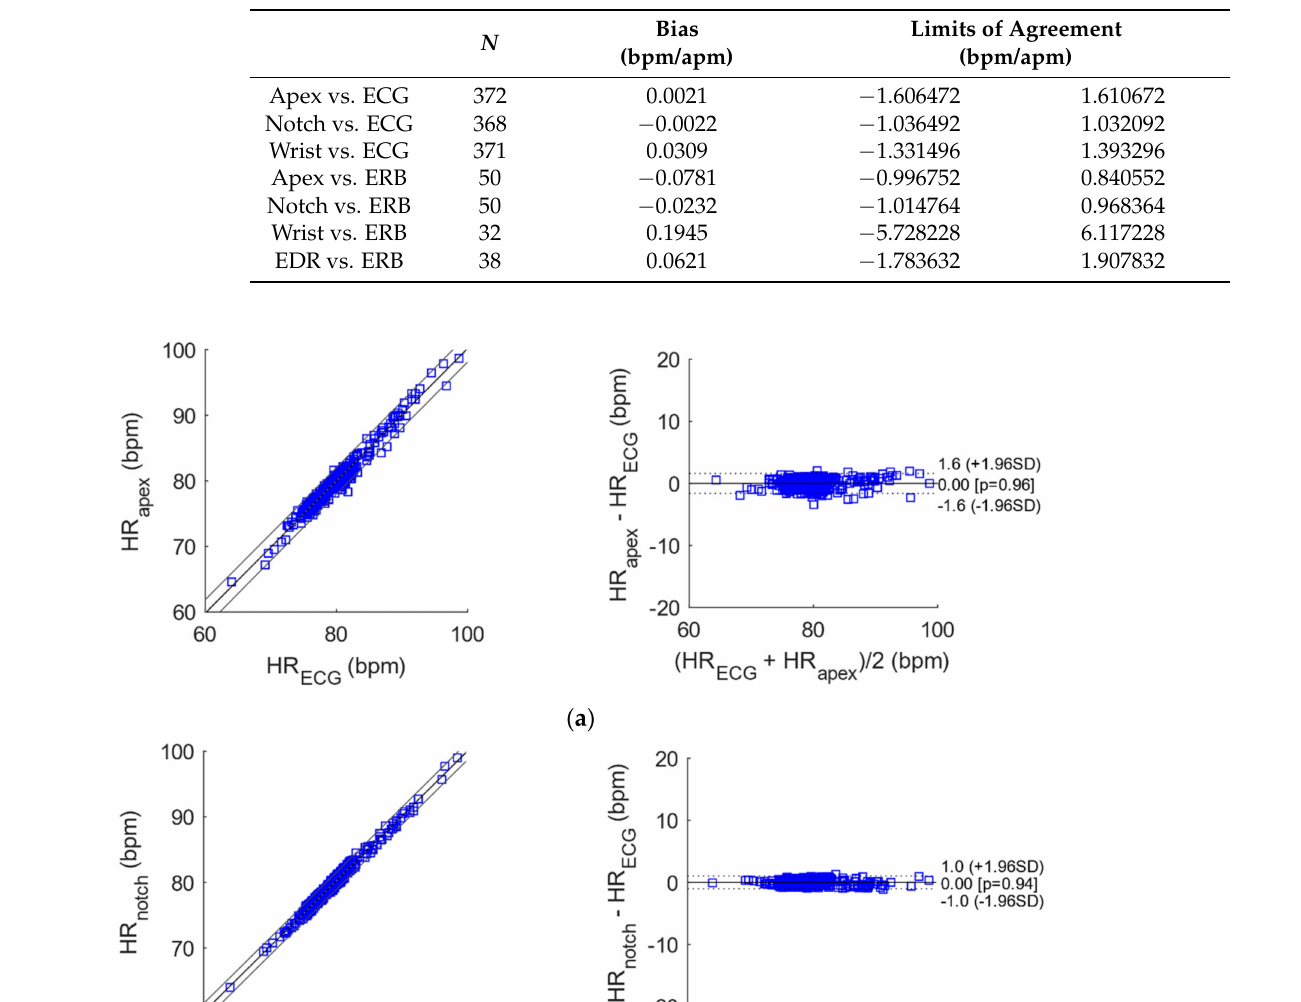
Table 3. Results of Bland-Altman analysis for instantaneous heart and respiratory rates.